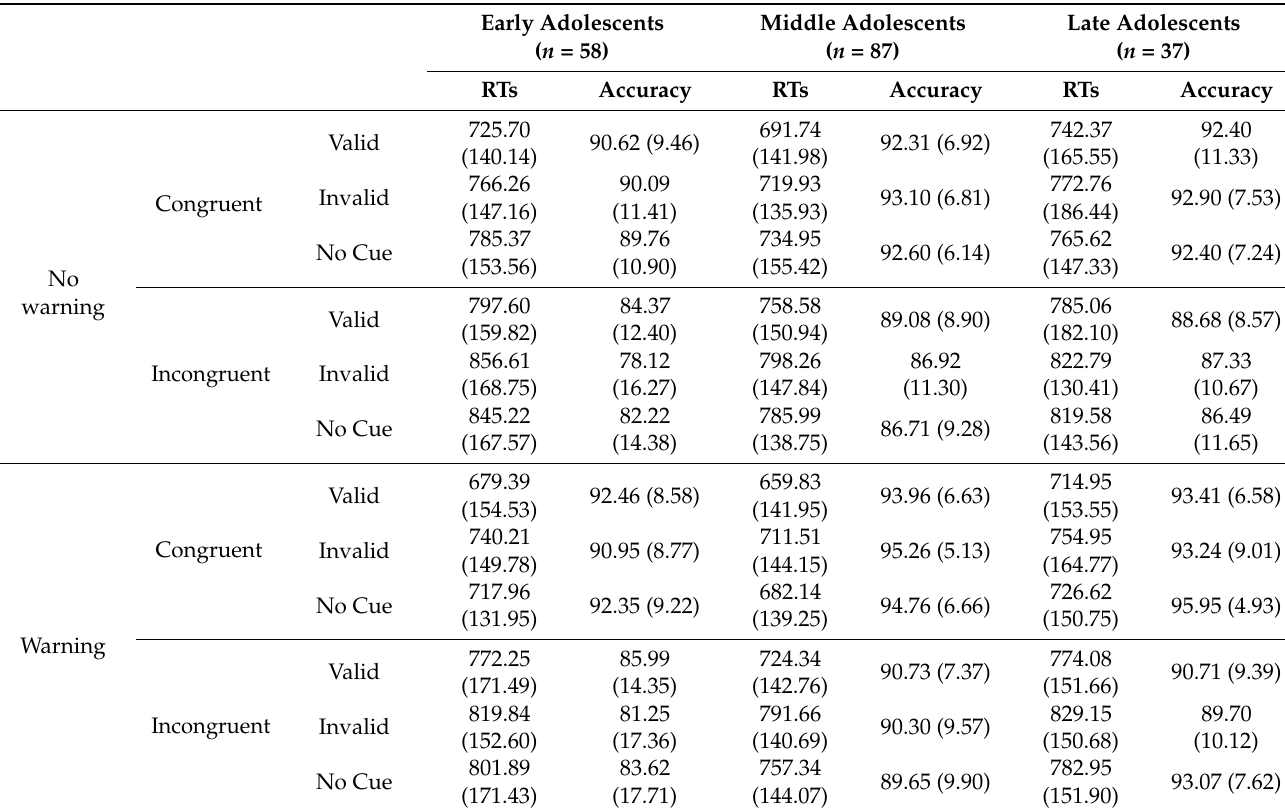
Table 1. Mean reaction times (in milliseconds) and percentage of accuracy for each experimental condition in the three groups of